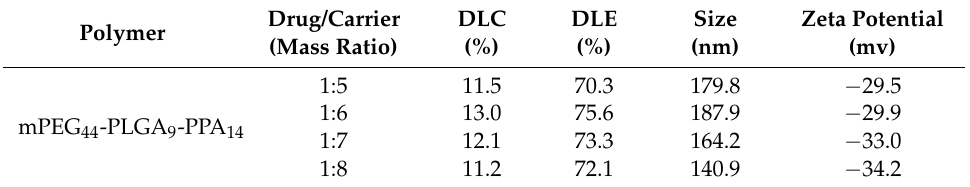
Table 5. Drug loading content (DLC) and drug loading efficiency (DLE) of Sorafenib (SFN)-loaded assembled micelles of different drug/carrier mass